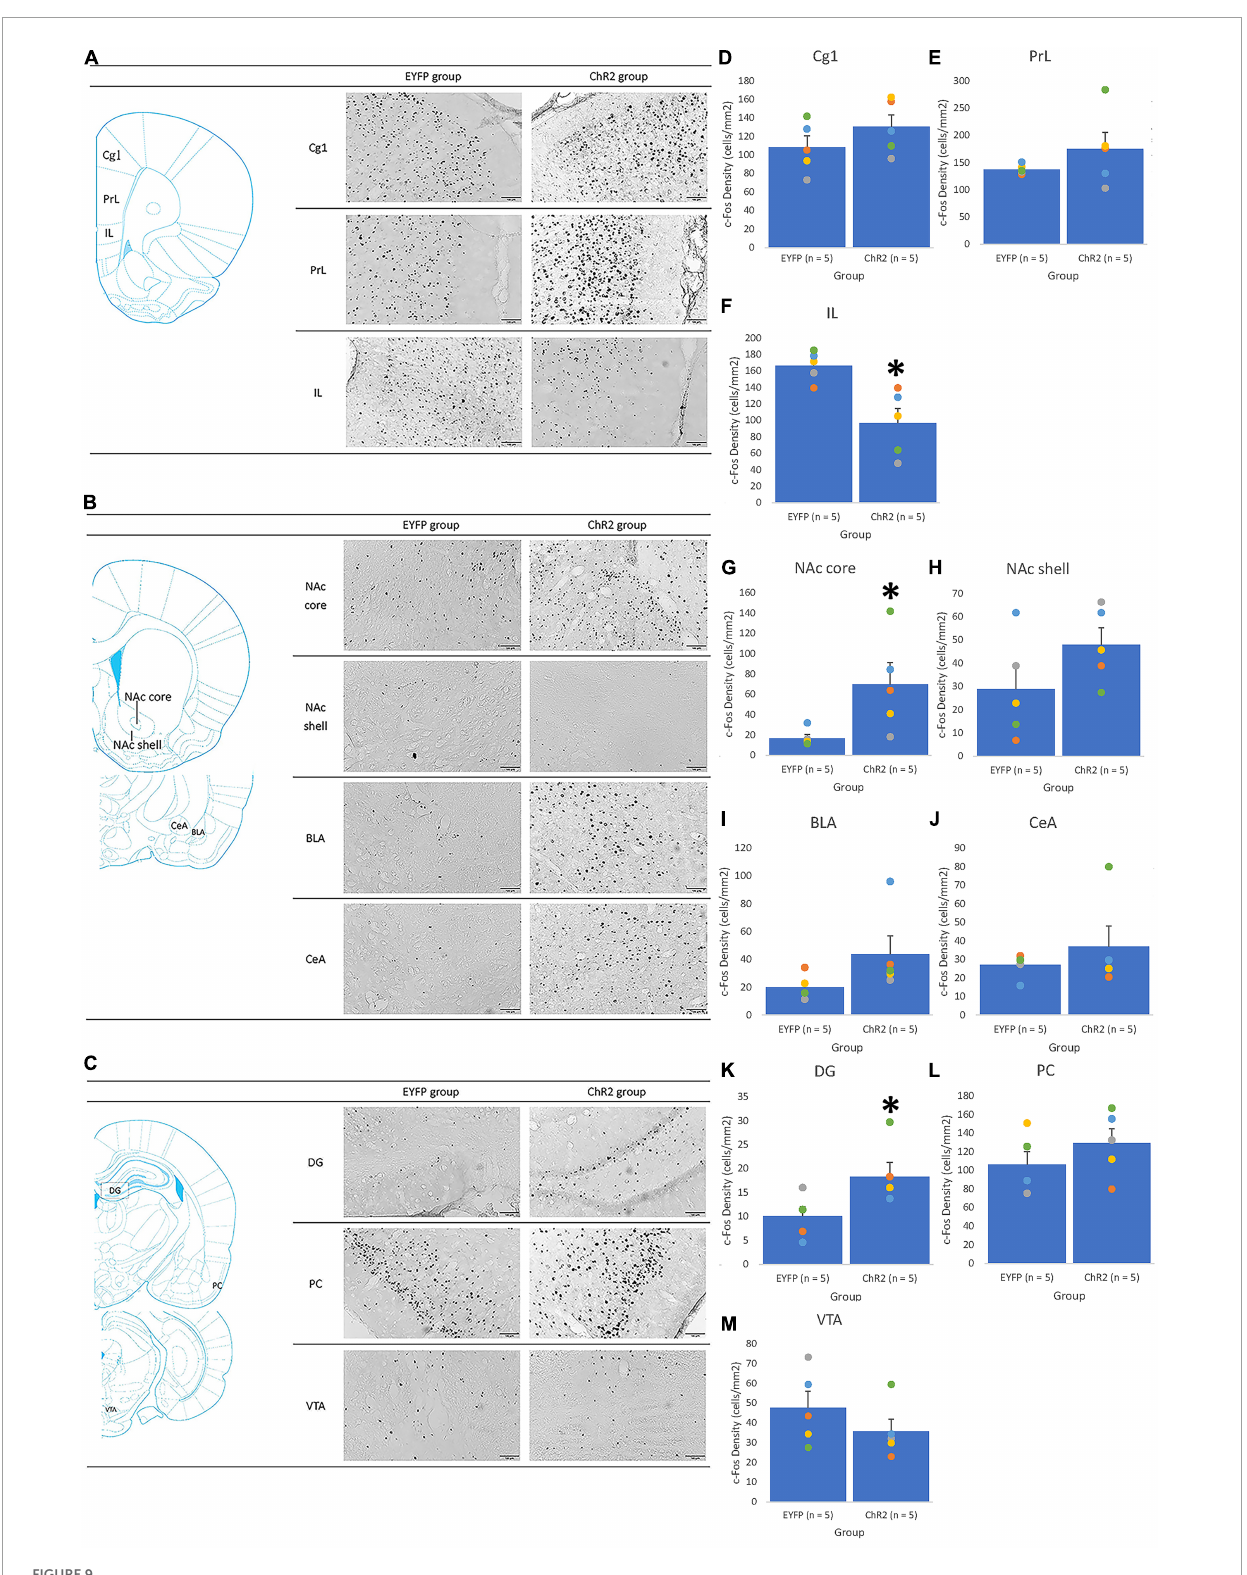
FIGURE9 The PrL photostimulation was given in extinction. An illustrated brain atlas showing (A) the cingulate cortex 1 (Cg1), prelimbic cortex (PrL), and infralimbic cortex (IL); (B) the nucleus accumbens core (NAc core), nucleus accumbens shell (NAc shell), basolateral amygdala (BLA), and central amygdala (CeA); (C) the dentate gyrus (DG), piriform cortex (PCl), and ventral tegmental area (VTA). c-Fos density in the (D) Cg1, (E) PrL, (F) IL, (G) NAc core, (H) NAc shell, (I) BLA, (J) CeA, (K) DG, (L) PC, and (M) VTA for the EYFP ( n = 5) and ChR2 ( n = 5) groups after PrL optical stimulation and morphine-induced CTA in extinction. ∗ p < 0.05 compared with the EYFP